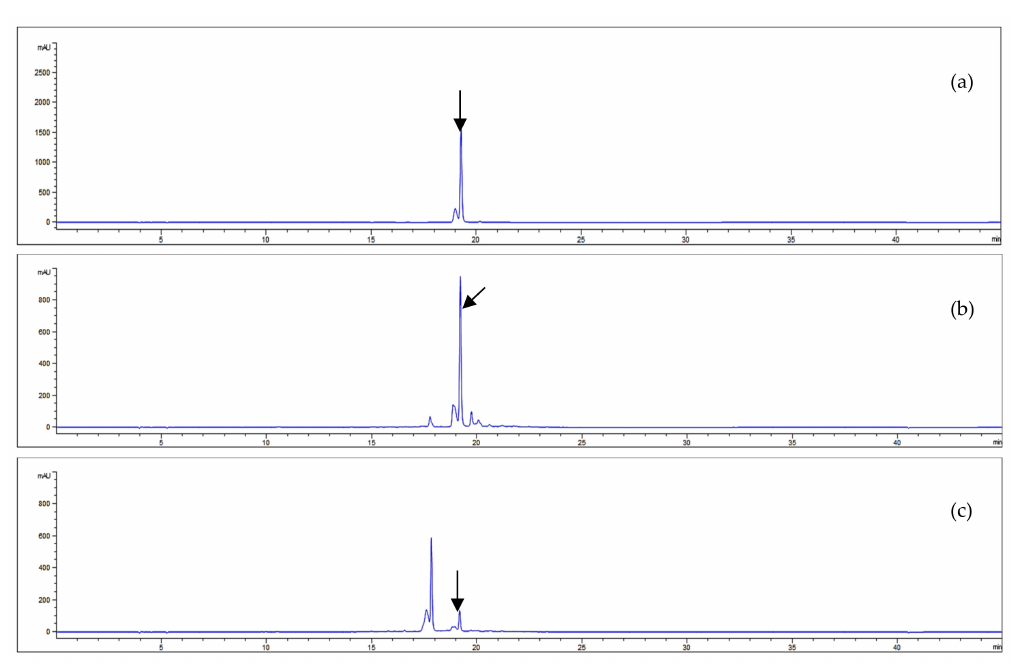
Figure 3. HPLC chromatograms of acteoside ( a ) and the EtOH extracts from A. distichum leaves ( b ) and stems ( c ) (330 nm).